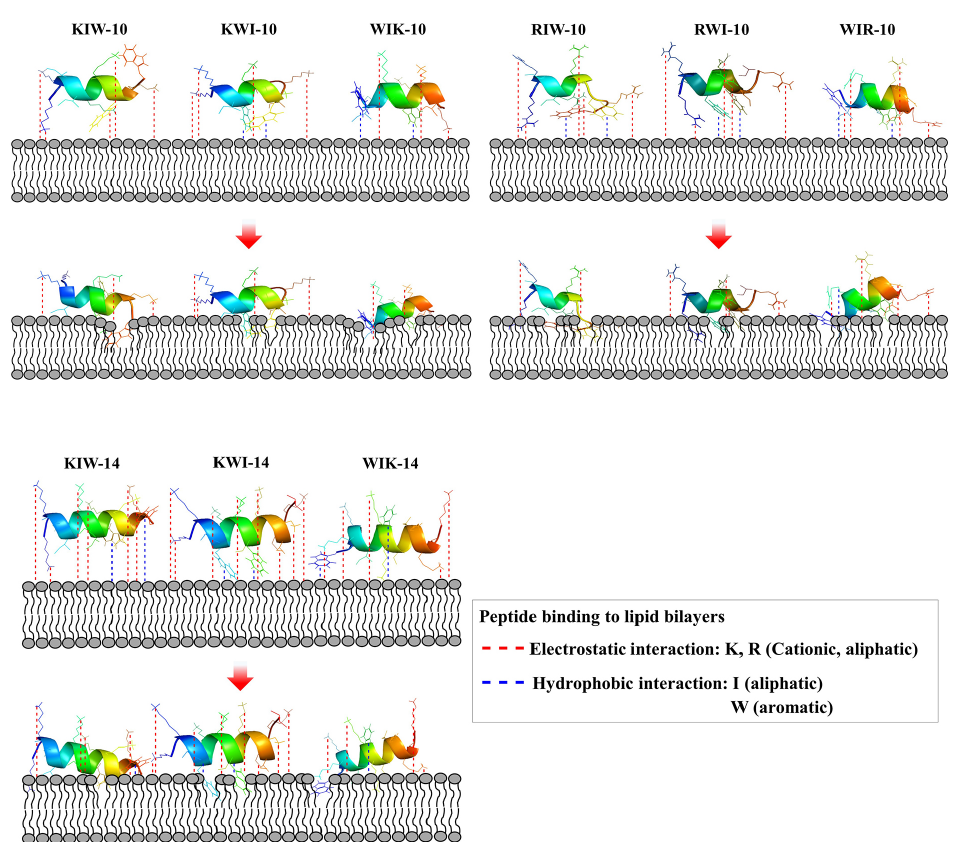
Figure 9. Schematic mode of action of the designed peptides in bacterial membranes. Red-dotted lines indicate electrostatic interaction between cationic amino acids and anionic head group of lipids. Hydrophobic interaction between hydrophobic amino acids and fatty acids of lipids.